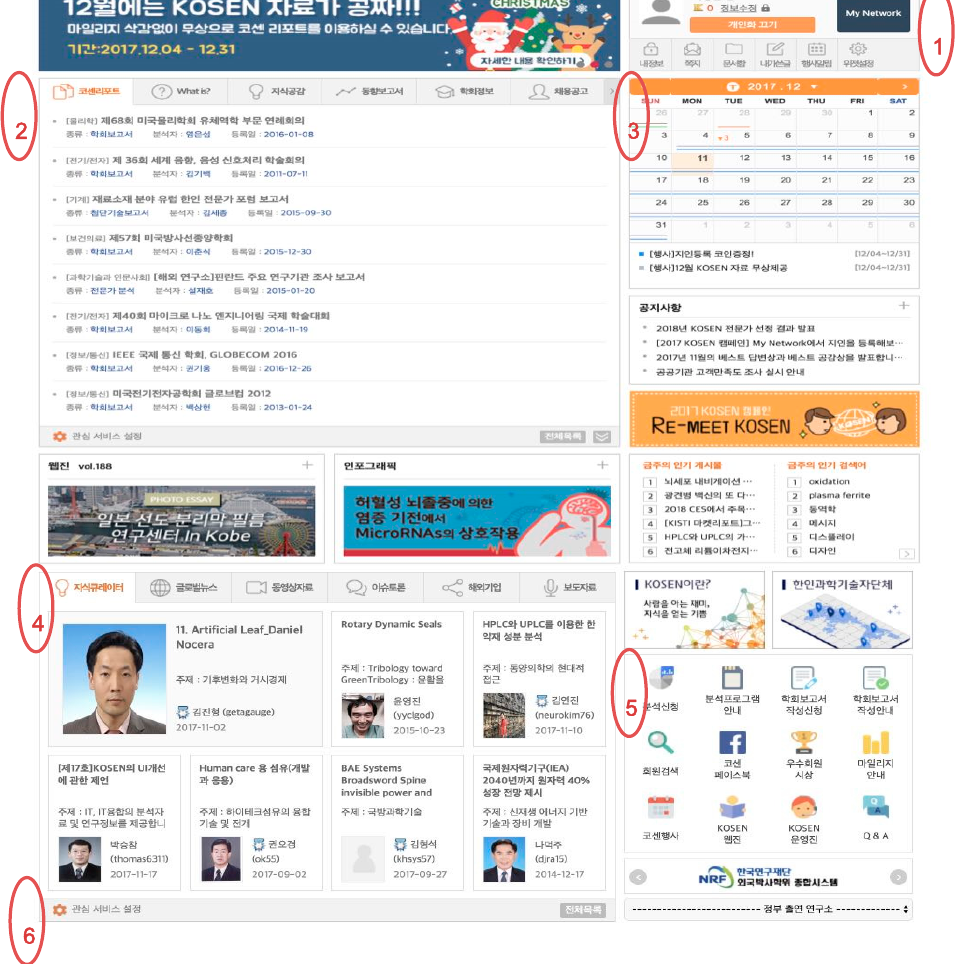
Figure 1. Item of KOSEN web page.